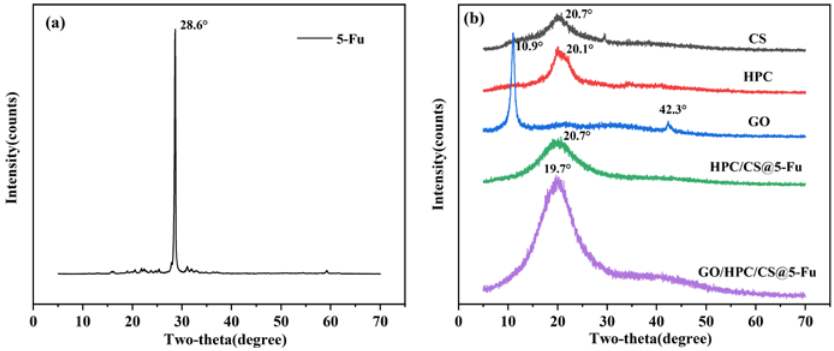
Figure 3. XRD patterns of ( a ) 5-Fu and ( b ) CS, HPC, GO, and aerogels.